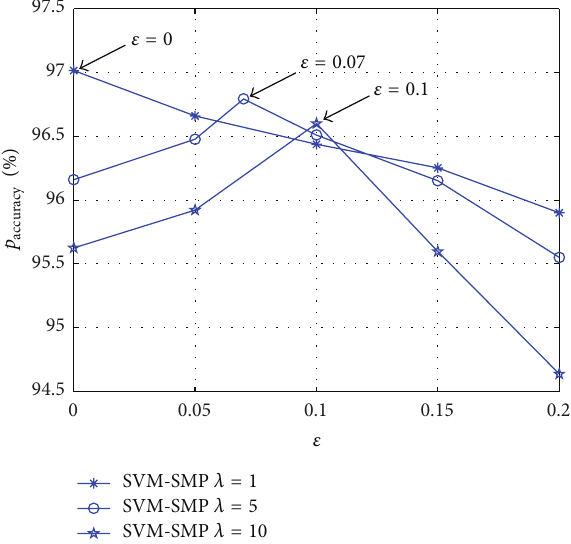
for CUs versus 𝜇 . accuracy